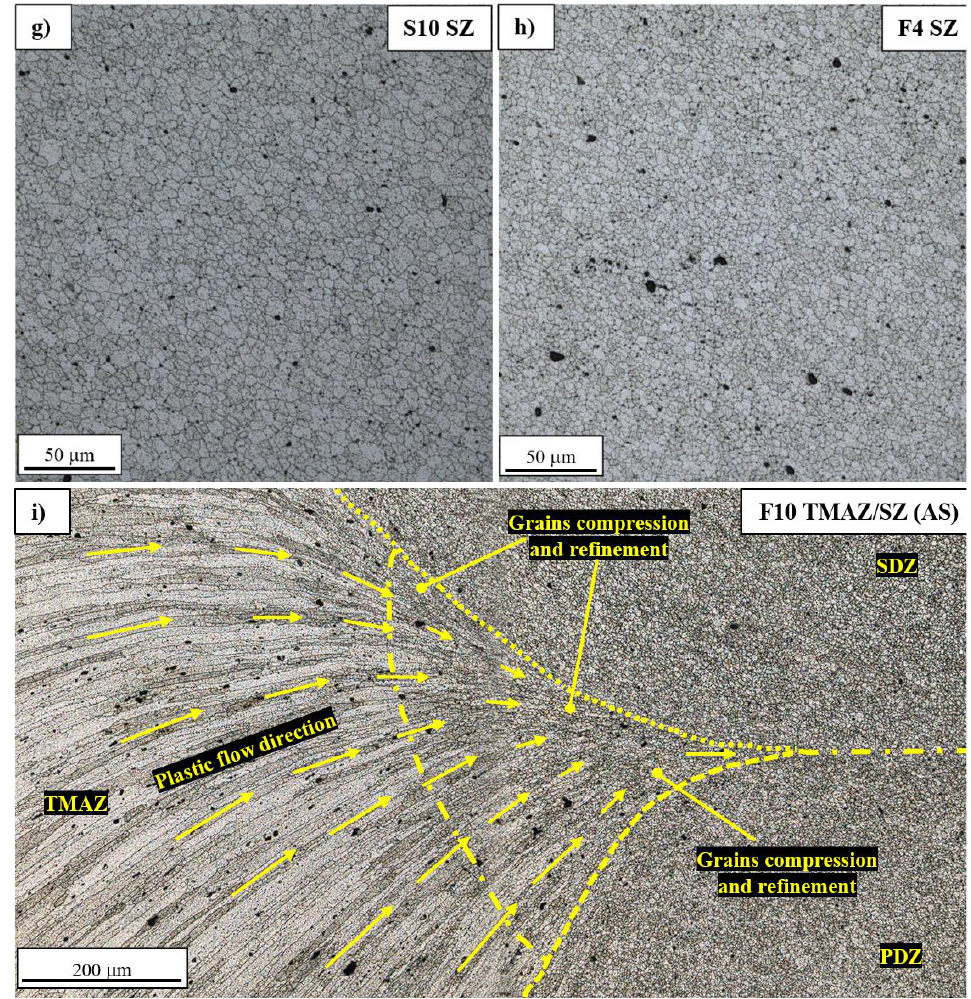
Figure 7. Microstructural images of the base material ( a ), HAZ in the F10 ( b ), F4 ( c ) and S10 ( d ) joints, TMAZ/SZ interface in the F4 ( e ) and S10 joints ( f ), SZ in the F4 ( g ) and S10 joints ( h ) and TMAZ/SZ interface in the F10 joint ( i ).